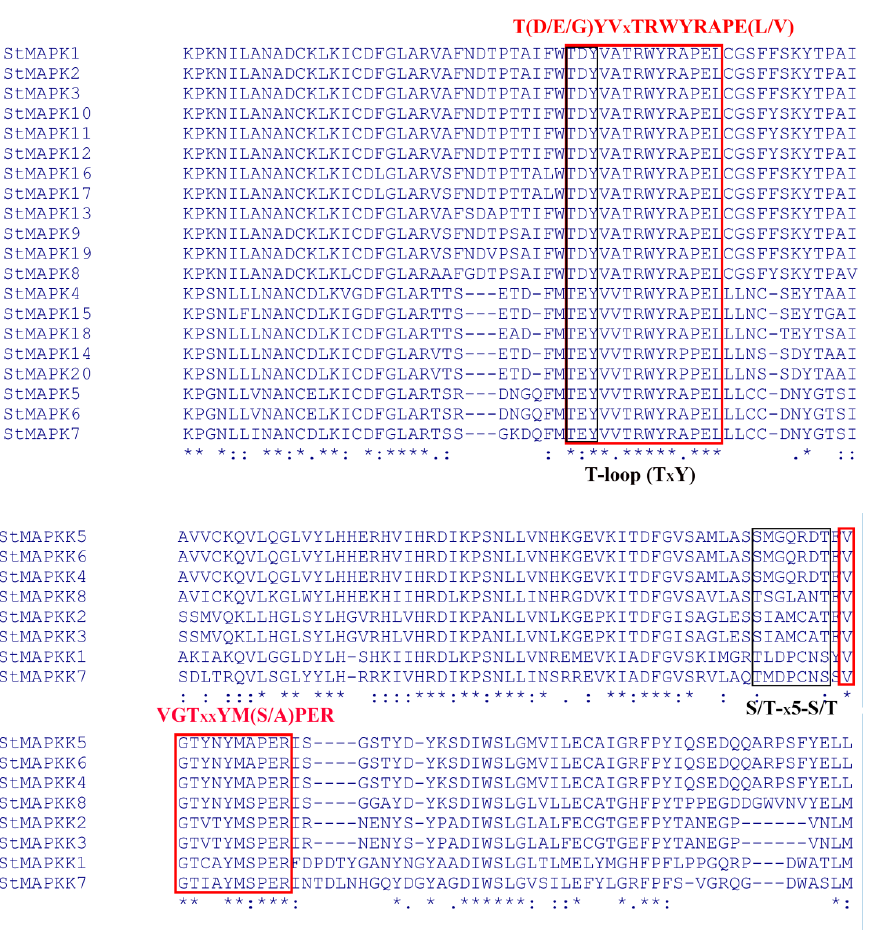
Figure 1. Multiple alignment of amino acid sequences between MAPK and MAPKK family members in potato.